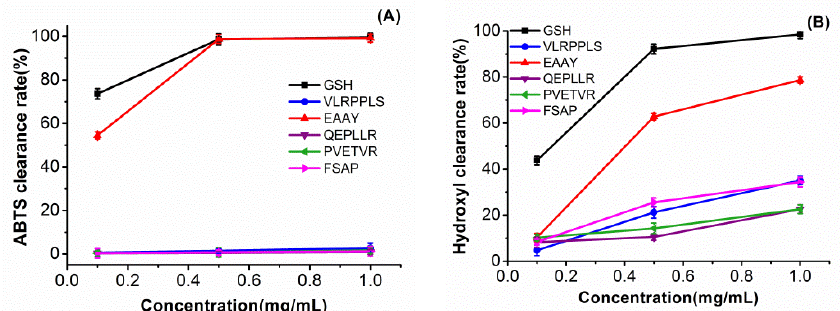
Figure 3. ABTS scavenging capacity of identified peptide ( A ) and hydroxyl scavenging capacity of identified peptide. ( B ) All experiments were in triplicate, n = 3.